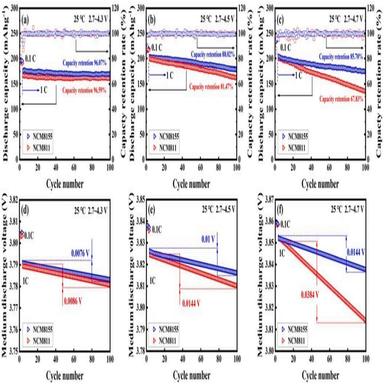
The decay curve of discharge capacity and medium discharge voltage during 100 cycles of NCM8155 and NCM811 materials under the voltage (a,d) 2.7–4.3 V, (b,e) 2.7–4.5 V, and (c,f) 2.7–4.7 V.